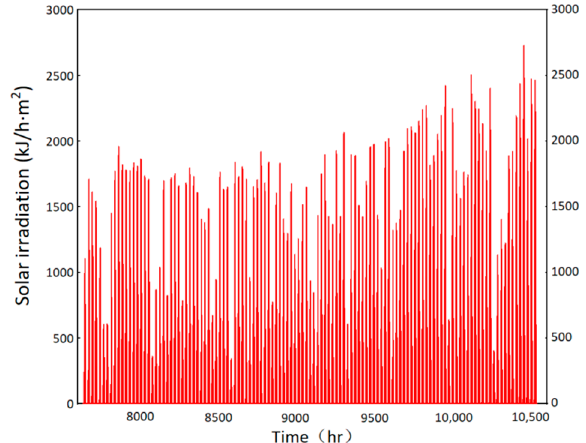
Figure 2. Solar irradiation during the heating season.